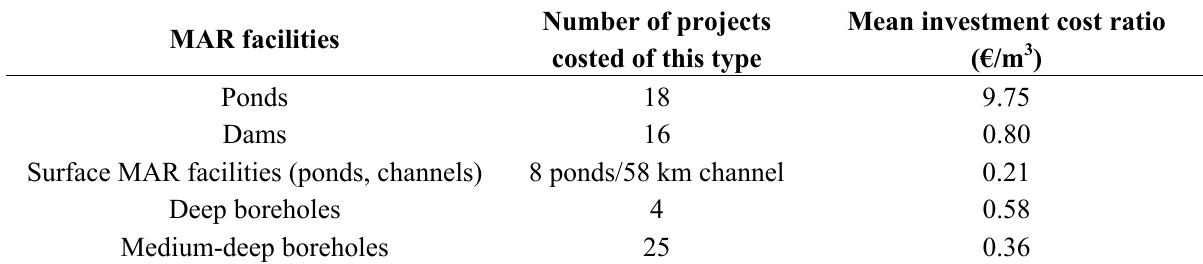
Table 2. Initial indicator to determine the suitability of MAR techniques according to costing based on the ratio between the investment costs and the initial storage volume. Mean costs taken from Tragsa Group projects performed for the Spanish Ministry of